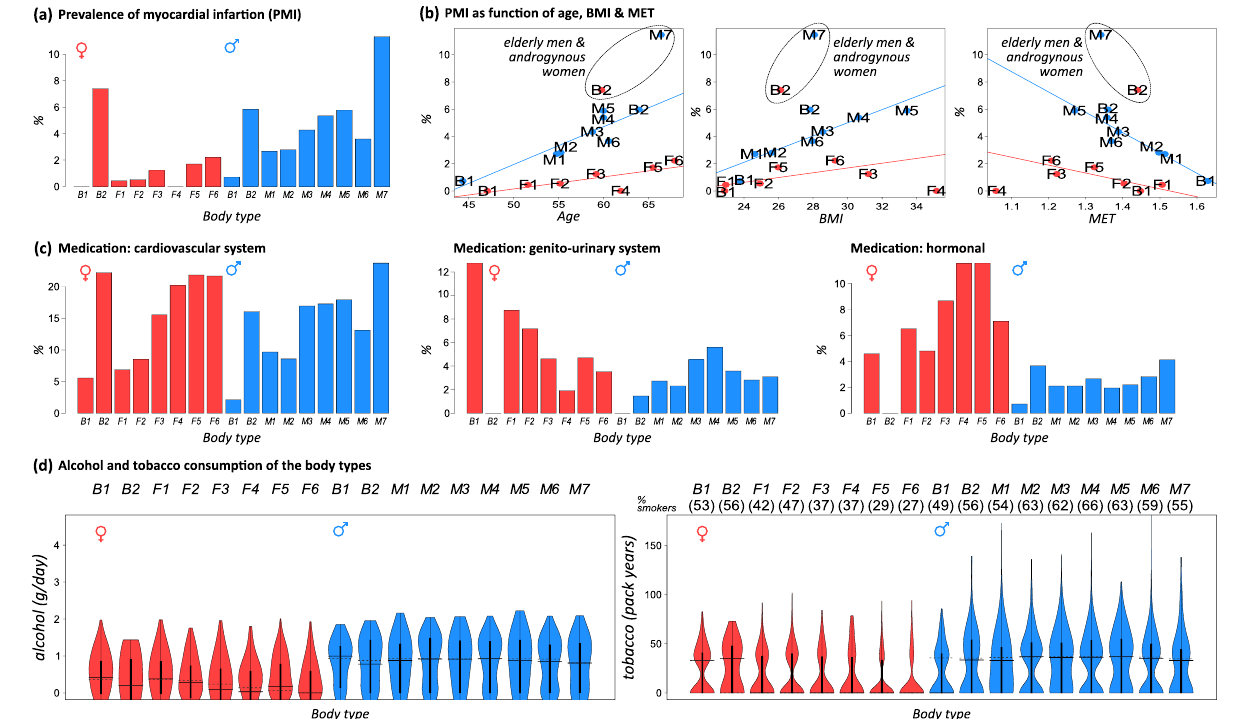
Fig. 8 Myocardial infarction prevalence, lifestyle factors, and medication in body types. a Prevalence of myocardial infarction is much smaller for female (1.1%) compared with male (4.1%) participants of the LIFE study where however women of the B2F type have a strikingly high PMI value (7.4%). b Plots of PMI as a function of age, BMI, and MET consequently reveal much steeper slopes for M-types than for F-types. Women of the androgynous body type B2F are disproportionately affected by myocardial infarction. c Medication frequency of the individuals of the body types (within 7 days before their examination in LIFE) with drugs of the ATC groups C (cardiovascular system), G (genito-urinary system and sex hormones), and H (systemic hormonal preparations, excluding sex hormones and insulins), which all show anomalies for B2F. d Violin plots of the lifestyle factors alcohol consumption and smoking strati fi ed by the body types. Alcohol consumption is higher for men than for women, and it slightly decreases with the mean age of the body types. Smoking among B-type women is more intense than among the other F-types and resembles that of men. Note that the violin plots re fl ect a bi-modal distribution for most of body types referring to non- smokers and smokers, respectively ( “ smokers ” here subsumes current and former smoking; see percentage of smokers in the body type as indicated in the